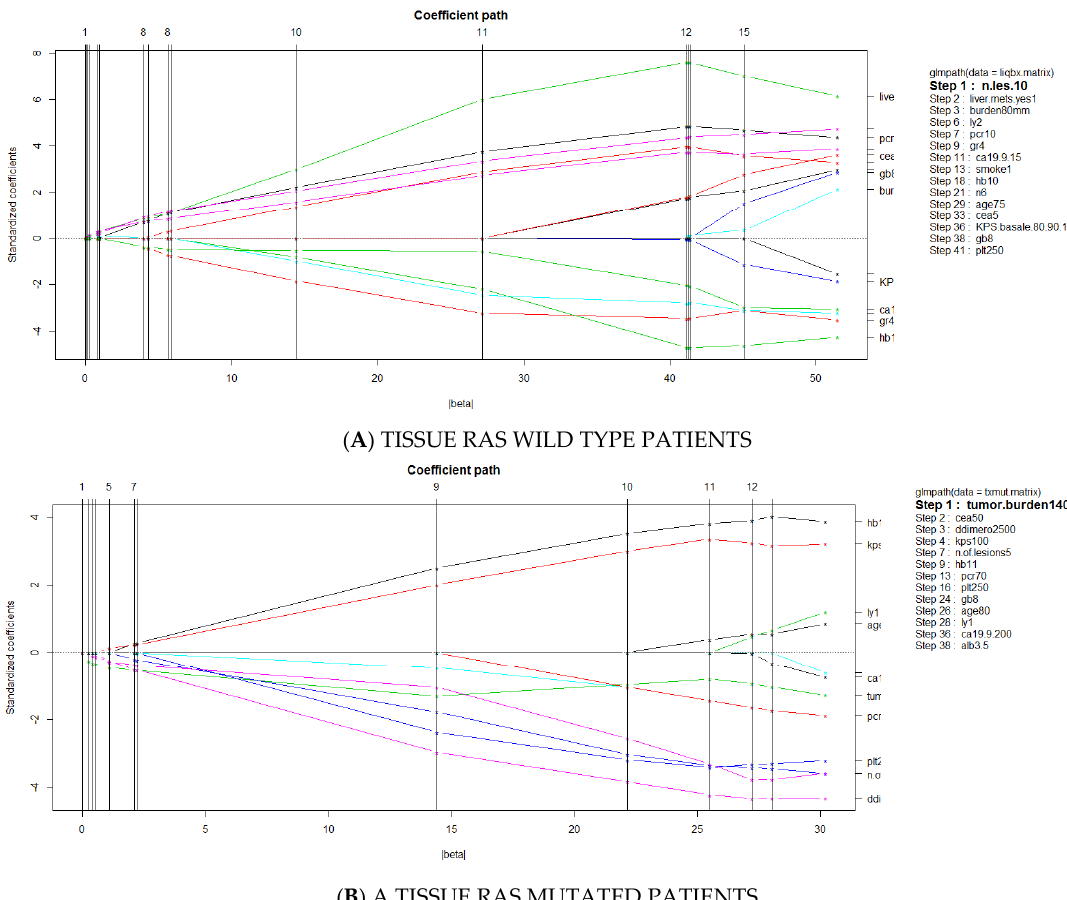
Figure 2. Path of Multivariate Logistic regression analysis with Least Absolute Shrinkage and Selection Operator (LASSO) approach for RAS discordance.